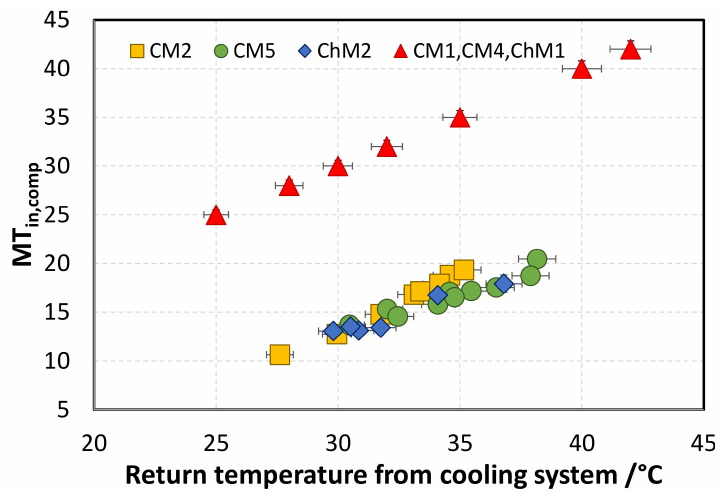
Figure 12. Variation of temperature of HTF in the compression unit with external temperature for different operating modes. For all the reported tests, LT out,comp = 5 ◦